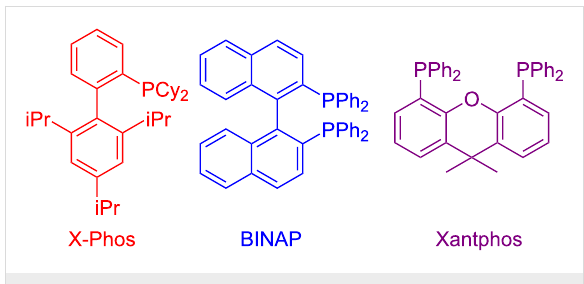
Figure 7: Structure of the ligands